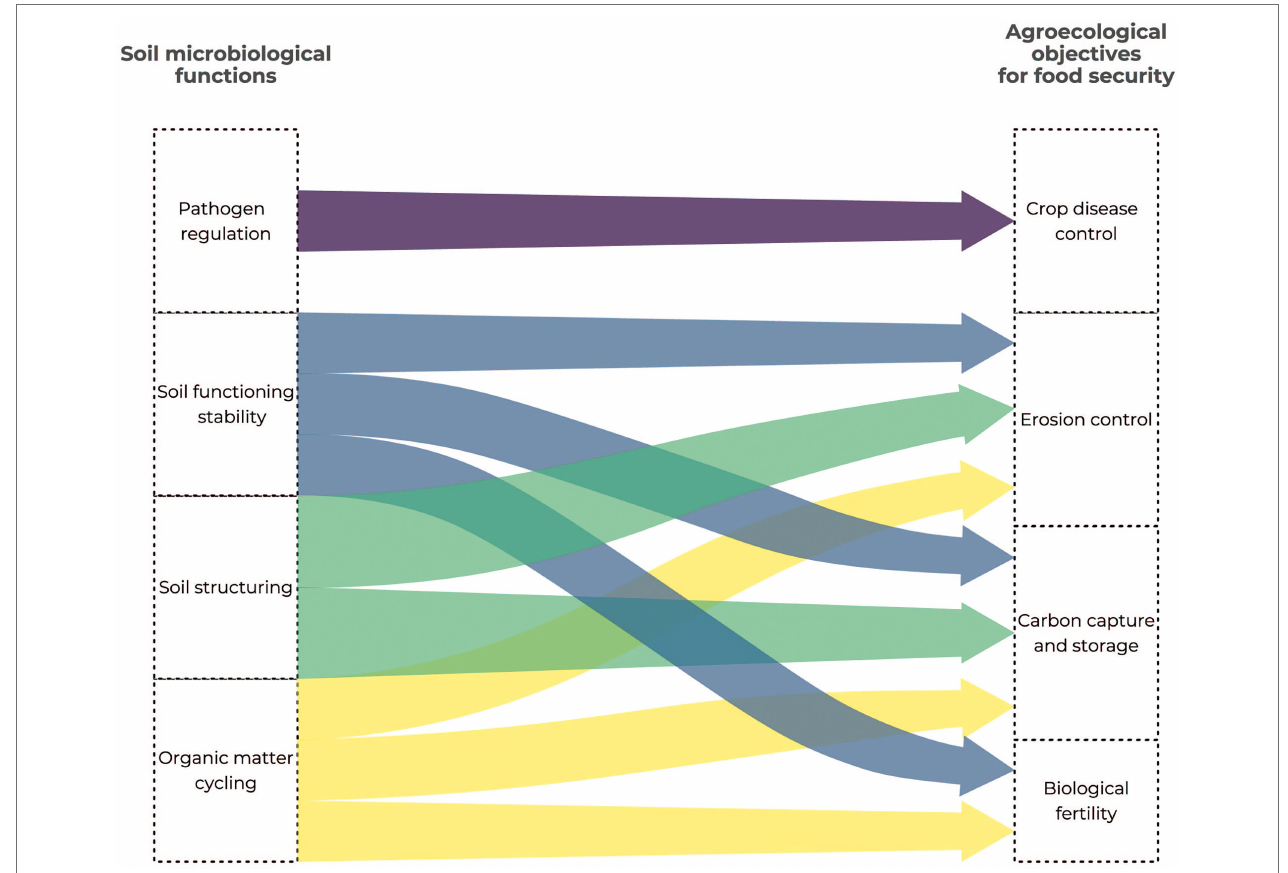
FIGURE 2 | Link between the soil microbiological functions and the agroecological objectives for food